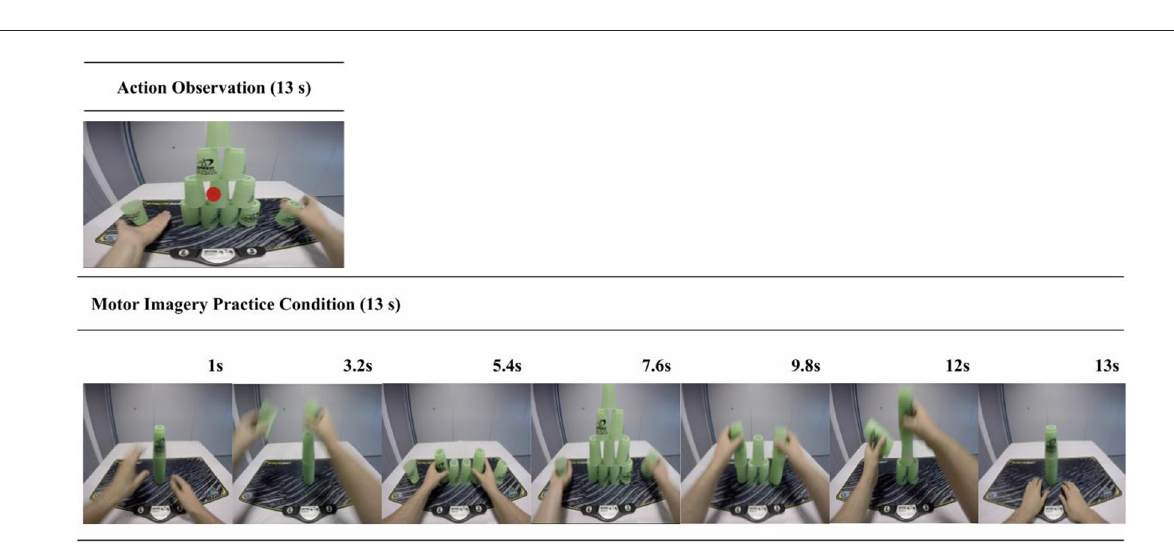
FIGURE3 AO and MI trial sequence example. This figure shows the structures for both the AO ( top panel) and the MI ( bottom panel) practice trials. In the AO condition participants verbally reported the color of a dot that appeared at the midpoint of the video in 25% of the trials. This aimed to control for attention toward the display and reduce the potential confound of spontaneous or unintended MI during the pure AO condition. In the MI condition participants viewed a series of still-images portraying a cup-stack sequence. These were designed to both cue and control for the time duration of the